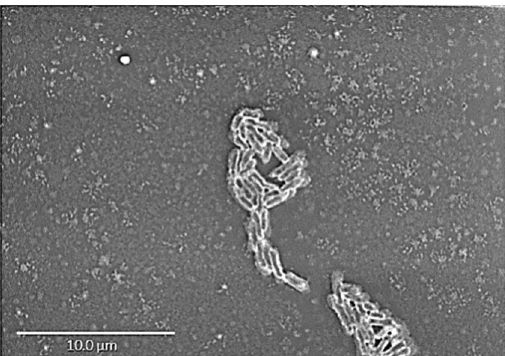
Figure 2. Scanning electron microscopy of Merdibacter massiliensis gen. nov., sp. nov., strain Marseille-P3254 using a Tabletop microscope TM 4000 plus (Hitachi, Tokyo, Japan). The scale bar represents 10 µ